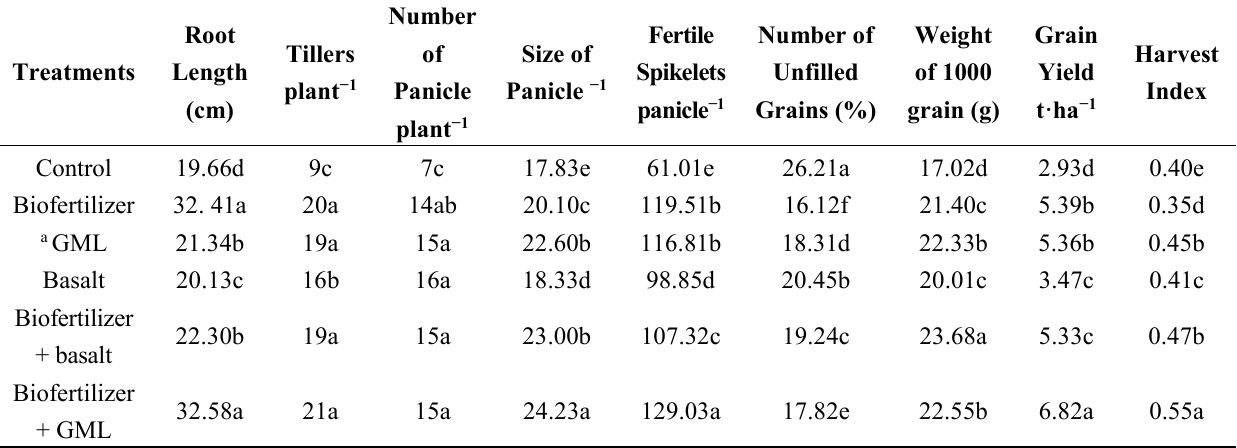
Table 4. Effects of biofertilizer, ground magnesium limestone (GML) and basalt application on the growth and yield of